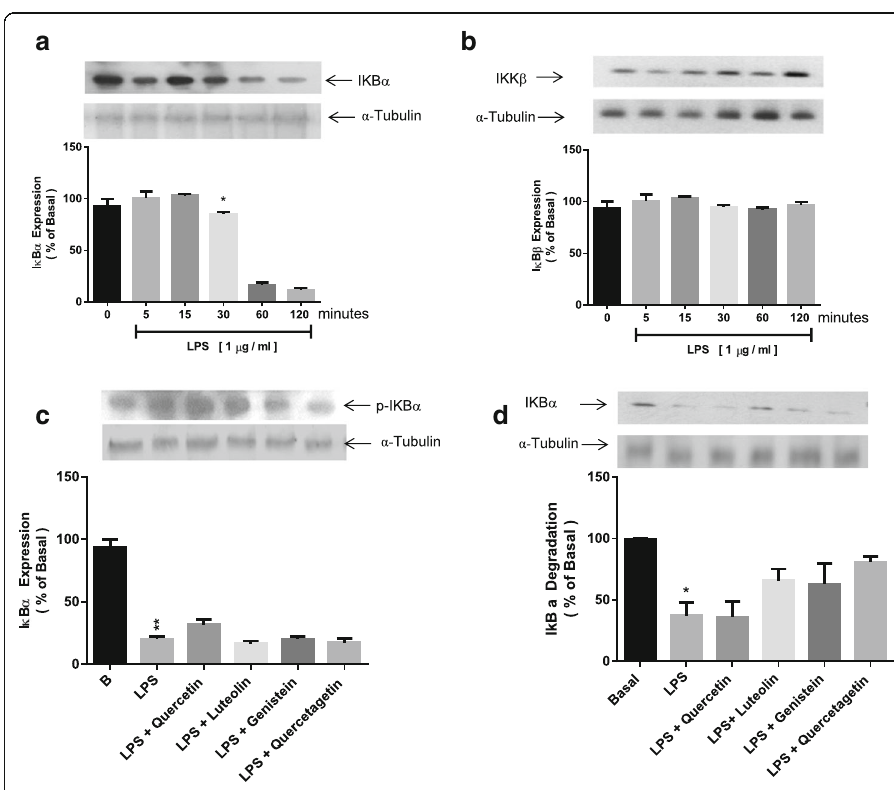
Fig. 5 The effect of LPS on IkB phophorylation and degradation and flavonoids on IkB degradation. The time course of I κ B α ( a ) and I κ B β degradation ( b ) and I κ B α phosphorylation ( c ). Cells were pre-treated with flavonoids (10 μ M) for 30 min and later exposed to LPS (1 μ g/ml) for 15 min, to then be lysed. d – H9c2 cells were incubated with flavonoids (10 μ M) for 30 min, then stimulated with LPS (1 μ g/ml) for 60 min. Whole cell extract was processed via sodium dodecyl sulfate – polyacrylamide gel electrophoresis (SDS-PAGE), and the membranes were blotted with I κ B-specific phosphoantibodies. The results are representative of three separate experiments. Densitometric analysis represents the means ± SEM. * p < 0.05 vs. untreated basal